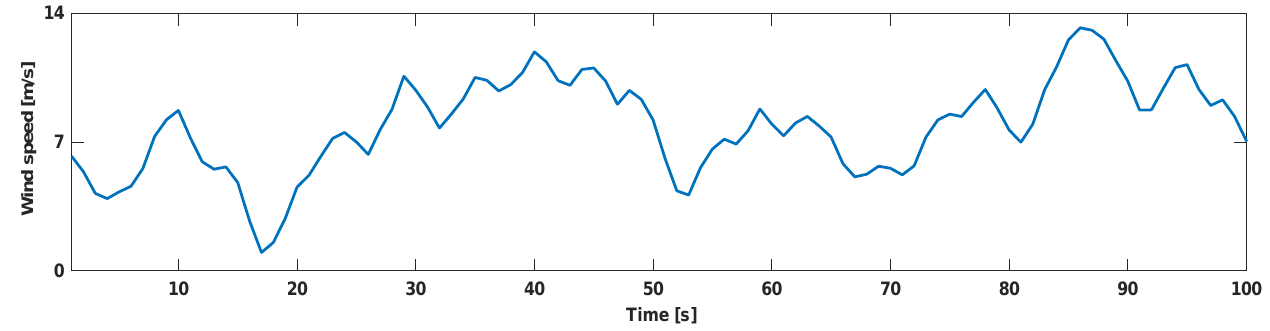
Figure 14. Example 2: Scenario 2: The trajectory of wind speed.